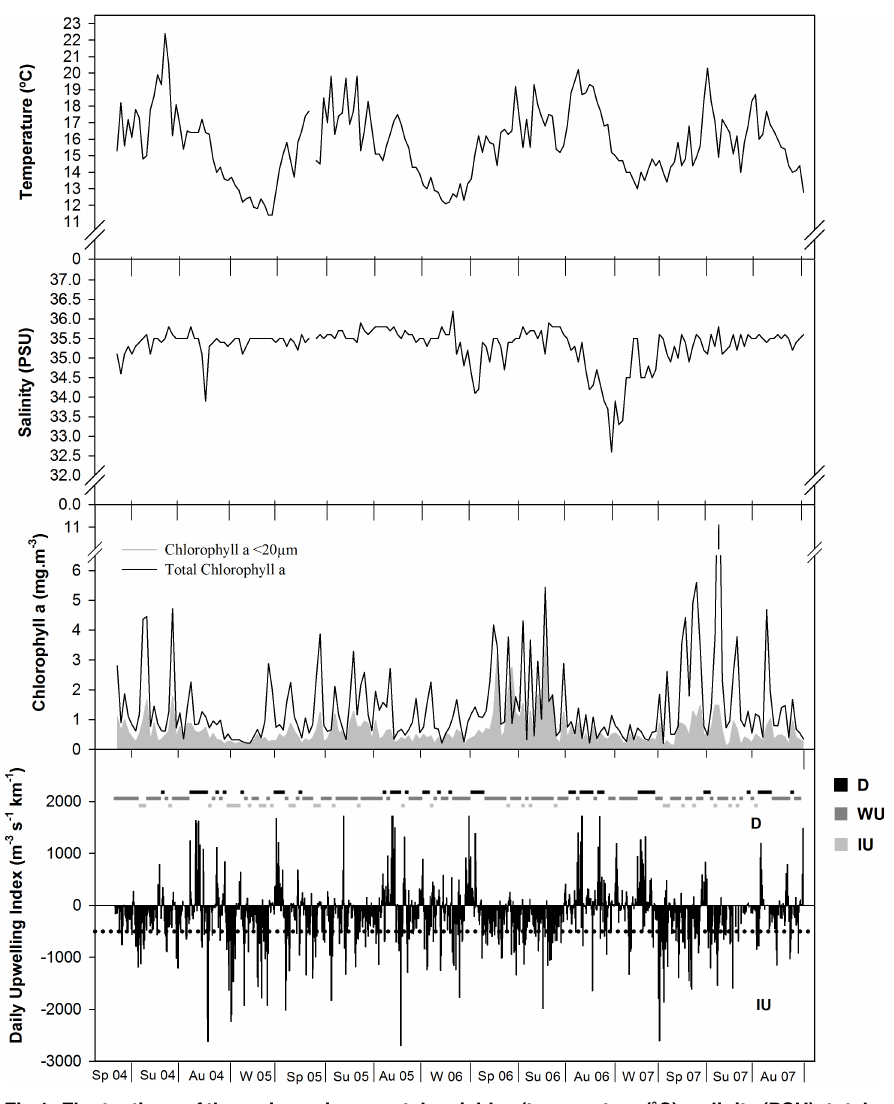
Fig 1. Fluctuations of the main environmental variables (temperature (˚C); salinity (PSU); total chlorophyll a (mg.m 3 ); chlorophyll a < 20 μ m(mg.m 3 ); daily upwelling index (m 3 .s -1 .km -1 ) and upwelling bar- corresponding to the mean of the upwelling from the week before the sampling day throughout the study period (2004–2007). Sp: spring; Su: summer; A: autumn; W: winter. D: downwelling; WU: weak upwelling; IU: intense